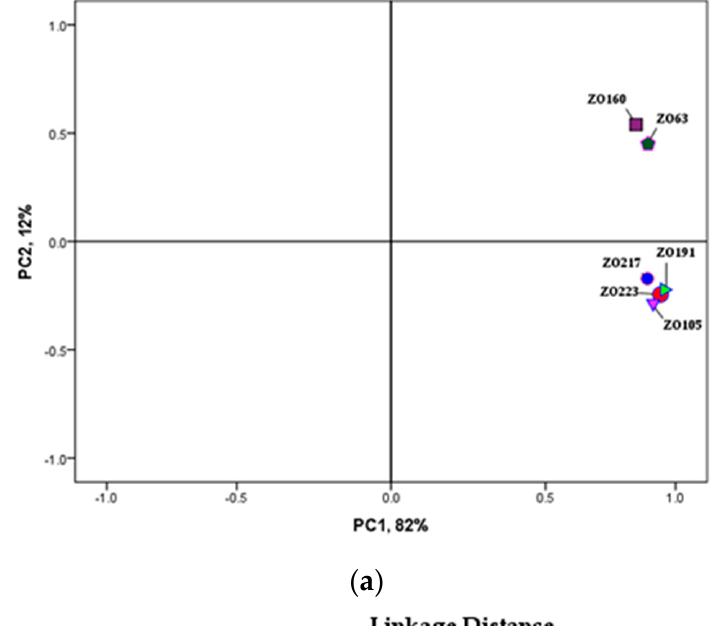
We included a total of 81 volatile organic compounds in the PCA and hierarchical cluster analysis (HCA), which were based on the Euclidean distance from the average value (two biological × two analytical (Figure 3).